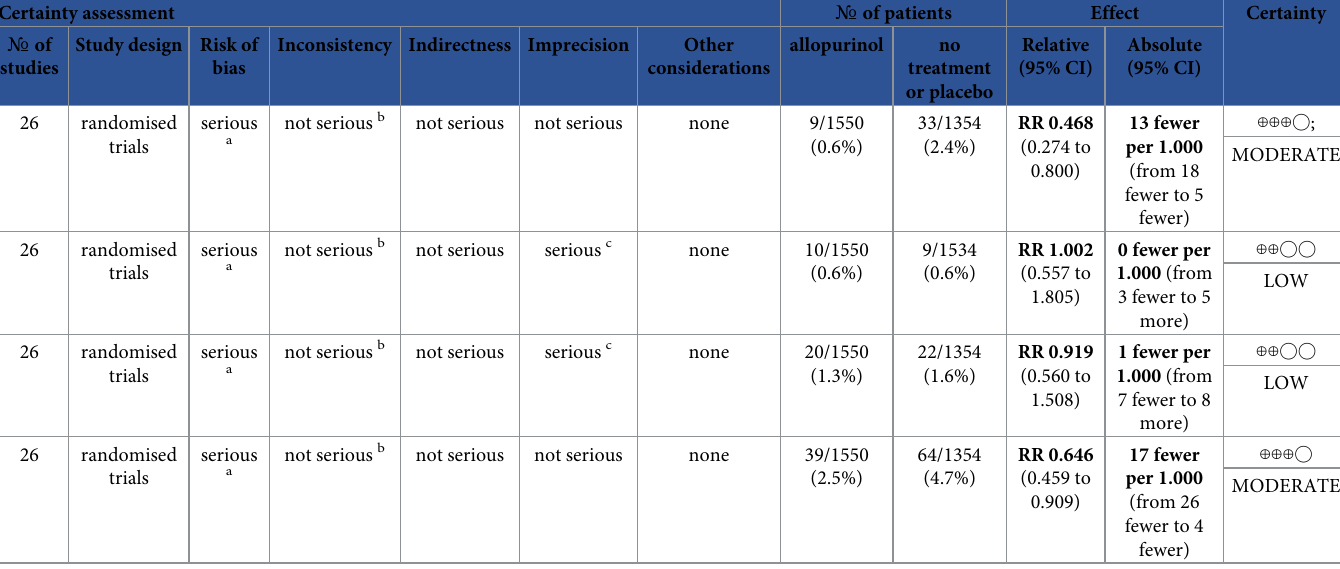
Table 2. Overview of quality assessment of evidence from RCTs according to GRADE-PRO system. Certainty assessment № of